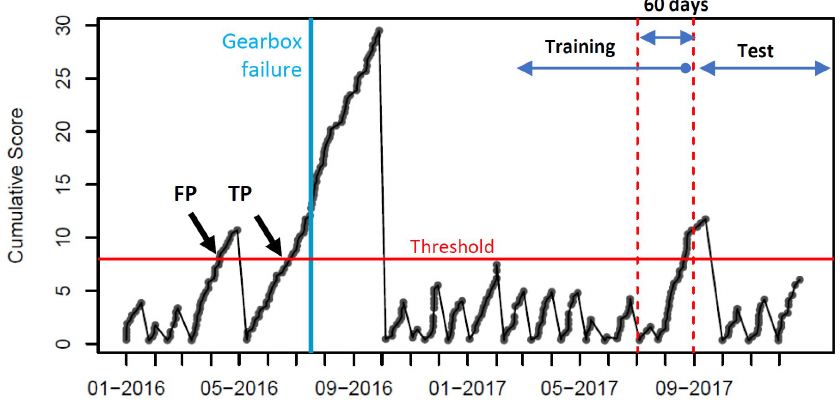
Figure 5. Illustration of how the combined LoMST and cumulative sum of anomaly score (LoMST- CUSUM) is used to establish failures detection. In this example, the blue line indicates the time at which a gearbox failure happened. The parameters are defined based on the training data in five